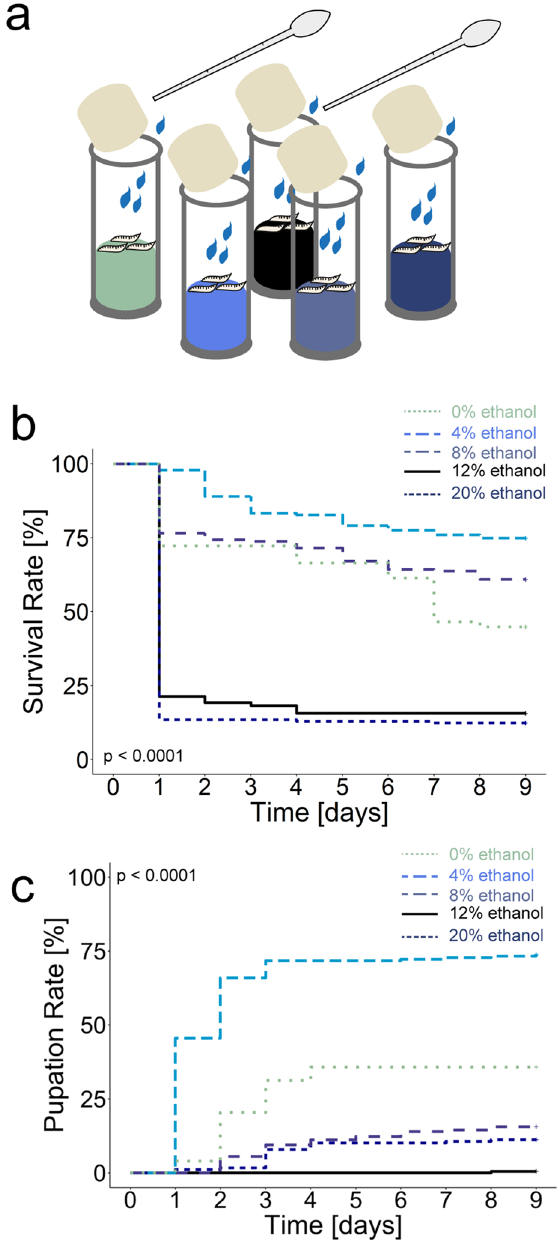
Figure 3. Larval survival on diets containing different concentrations of ethanol. ( a ) Scheme of the experimental procedure. Independent groups of 12 second instar Canton-S larvae were put into food vials that contained an agarose substrate plus different concentration of ethanol. Surviving of larvae and pupae were counted every 24 h. Water was added every 24 h to avoid dehydration. Pupation was used as measure of survival. ( b ) Diagram shows Kaplan–Meier survival curves of larvae. Larvae were put either on 0% (green), 4% (light blue), 8% (blue), 12% (black), or 20% ethanol (dark blue) diet for eight days. 12% and 20% ethanol significantly reduced larval survival as most of the animals died within one day ( survival rate 12%Ethanol = 21.40%, survival rate 20%Ethanol = 12.40%). Larvae reared on 0% and 8% ethanol showed a nearly similar survival (Log-Rank-test, p < 0.001, survival rate 0%Ethanol = 44.90%, survival rate 8%Ethanol = 60.90%). In contrast 4% ethanol diet significantly increased larval survival compared to the 0% ethanol control diet (Log-Rank-test, p < 0.001, survival rate 4%Ethanol = 74.90%). ( c ) Diagram shows Kaplan–Meier survival curves of the related pupation rates of the surviving animals shown above raised at 0% (green), 4% (light blue), 8% (blue), 12% (black), or 20% ethanol (dark blue) diet. 4% ethanol diet significantly increased the pupation rate compared to larvae reared at 0% ethanol diet (Log-Rank-test, p < 0.001, pupation rate 0%Ethanol = 35.8%, pupation rate 4%Ethanol = 73.80%). In contrast 8%, 12%, and 20% ethanol diet significantly reduced the pupation rate compared to larvae reared at 0% ethanol diet (Log-Rank-test, p 0%-8%Ethanol < 0.001, p 0%-12%Ethanol < 0.001, p 0%-20%Ethanol < 0.001, pupation rate 8%Ethanol = 15.6%, pupation rate 12%Ethanol = 0.5%, pupation rate 20%Ethanol = 12.2%). Single scores and statistical tests underlying the different survival curves are documented in the Supplementary material. Sample size for each Kapplan-Meier survival curve is n =